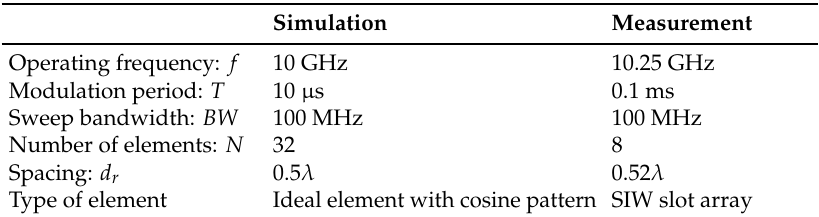
Table 1. Radar parameters for simulation and measurement.